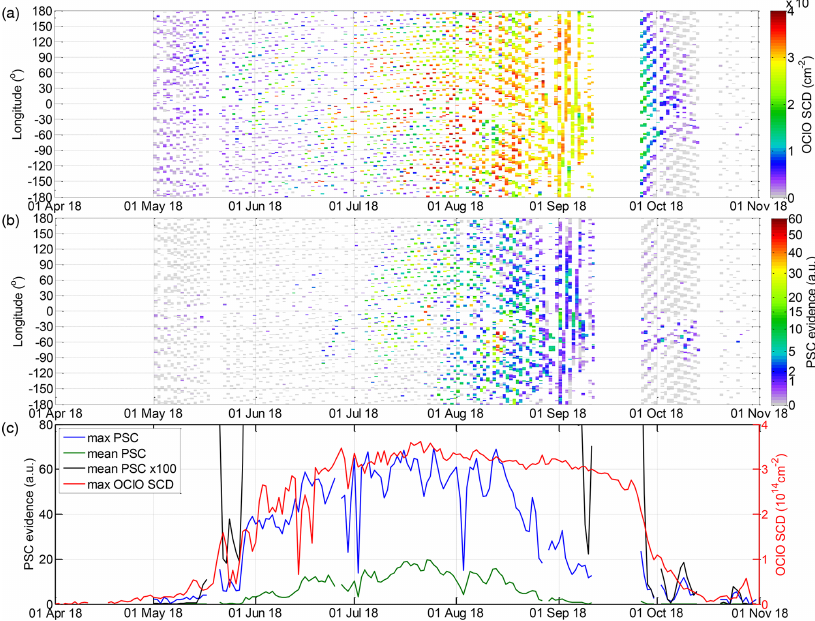
Figure 12. Same as Fig. 3 but for the Antarctic winter